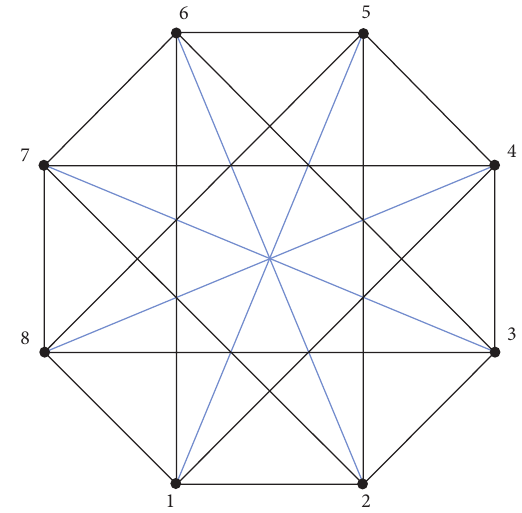
Figure 1: The Toeplitz graph T